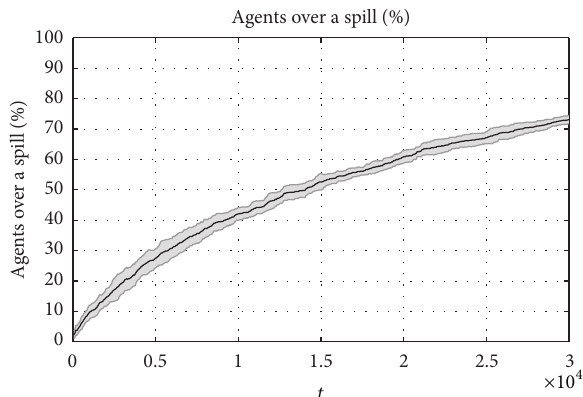
Figure 3: Percentage of agents on an oil slick with respect to time (in seconds). Ten different experiments have been carried out, showing the average and variance.